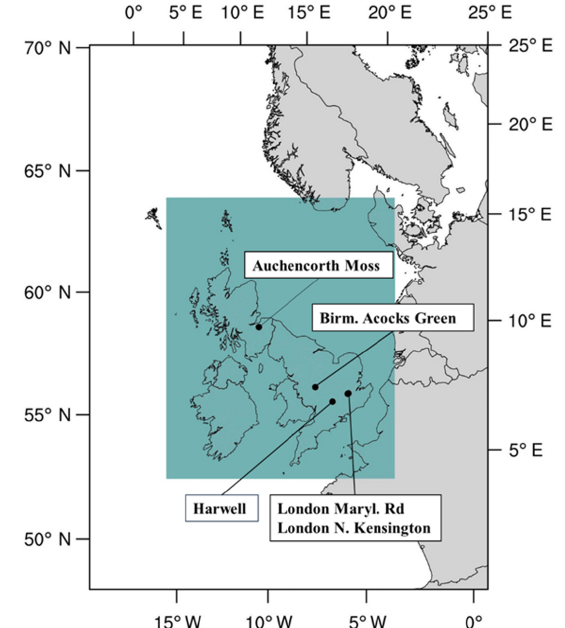
Figure 1. The inner shaded box illustrates the EMEP4UK model British Isles domain, which is modelled at 5km × 5km horizon- tal resolution. The locations of five grid cells used for uncertainty quantification and sensitivity analysis for monthly average mod- elled concentrations of O 3 , NO 2 , and PM 2 . 5 are